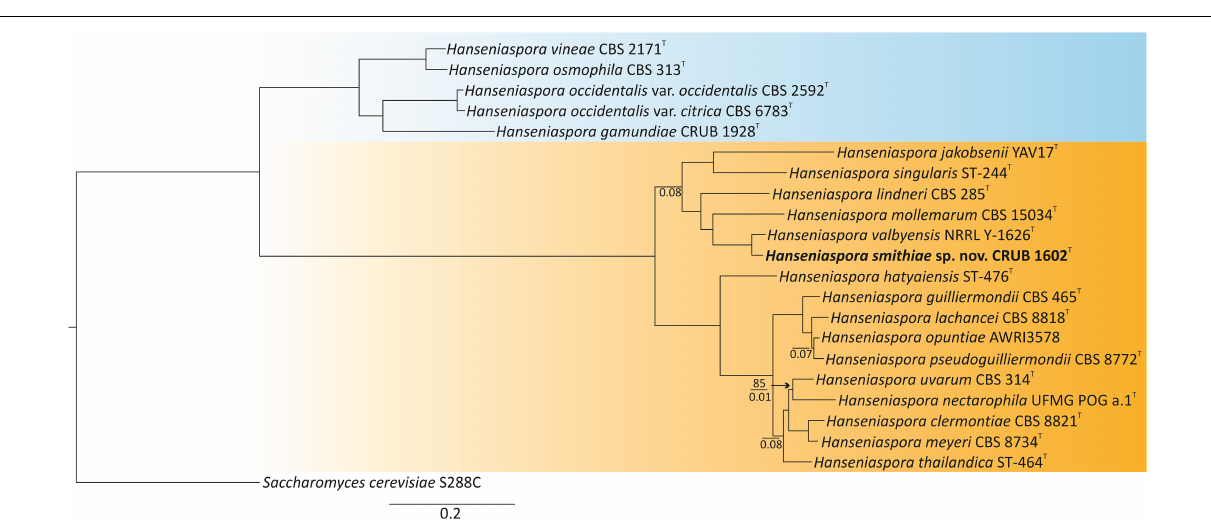
FIGURE 2 | Phylogenomic tree showing the placement of the novel species Hanseniaspora smithiae sp. nov. CRUB 1602 T . The ML tree was constructed based on a concatenated alignment of 251 orthologous, single-copy BUSCO proteins. Bootstrap values are shown only on branches where it is lower than 100% (above the line), while internode certainty (IC) values below 0.1 are shown below the line. Slower-evolving (SEL) and faster-evolving (FEL) lineages, according to Steenwyk et al. (2019), are colored in blue and orange, respectively. Saccharomyces cerevisiae was used as the